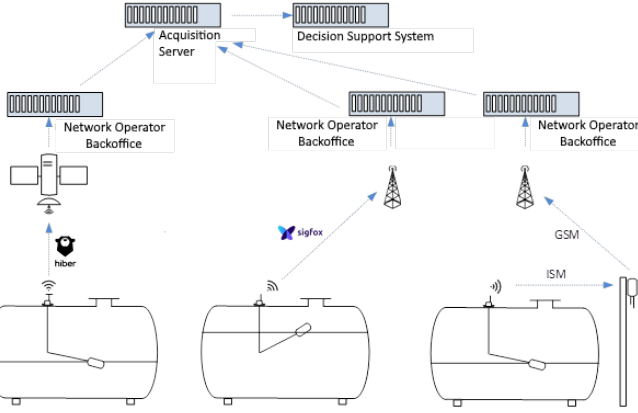
Figure 1. Illustration of the LPG monitoring environment.